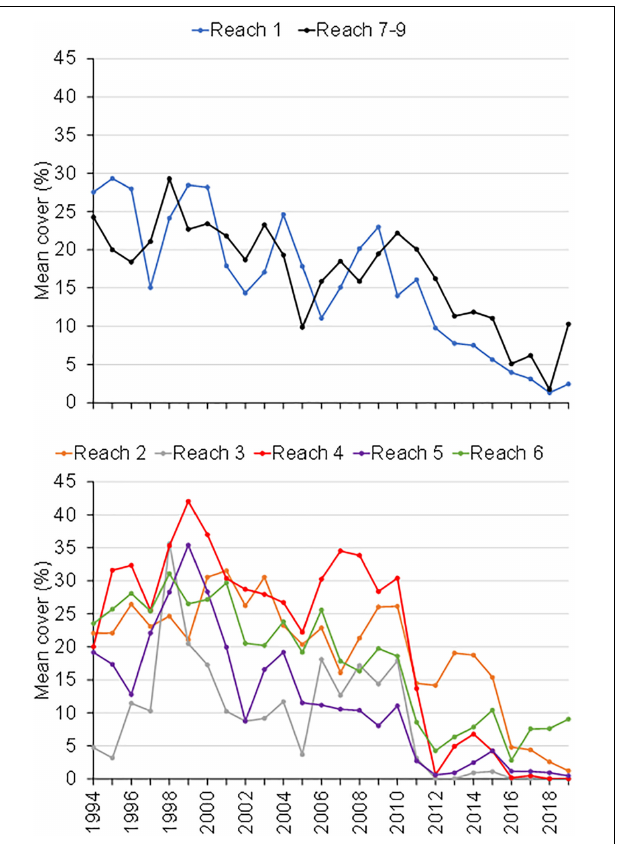
FIGURE 8 | Mean percent cover of seagrass in each reach during